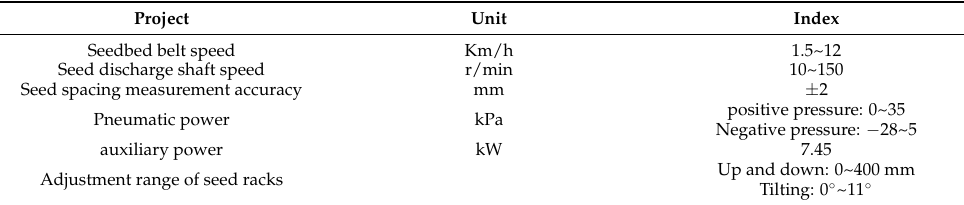
Table 2. Performance Parameters of JPS-12 Test